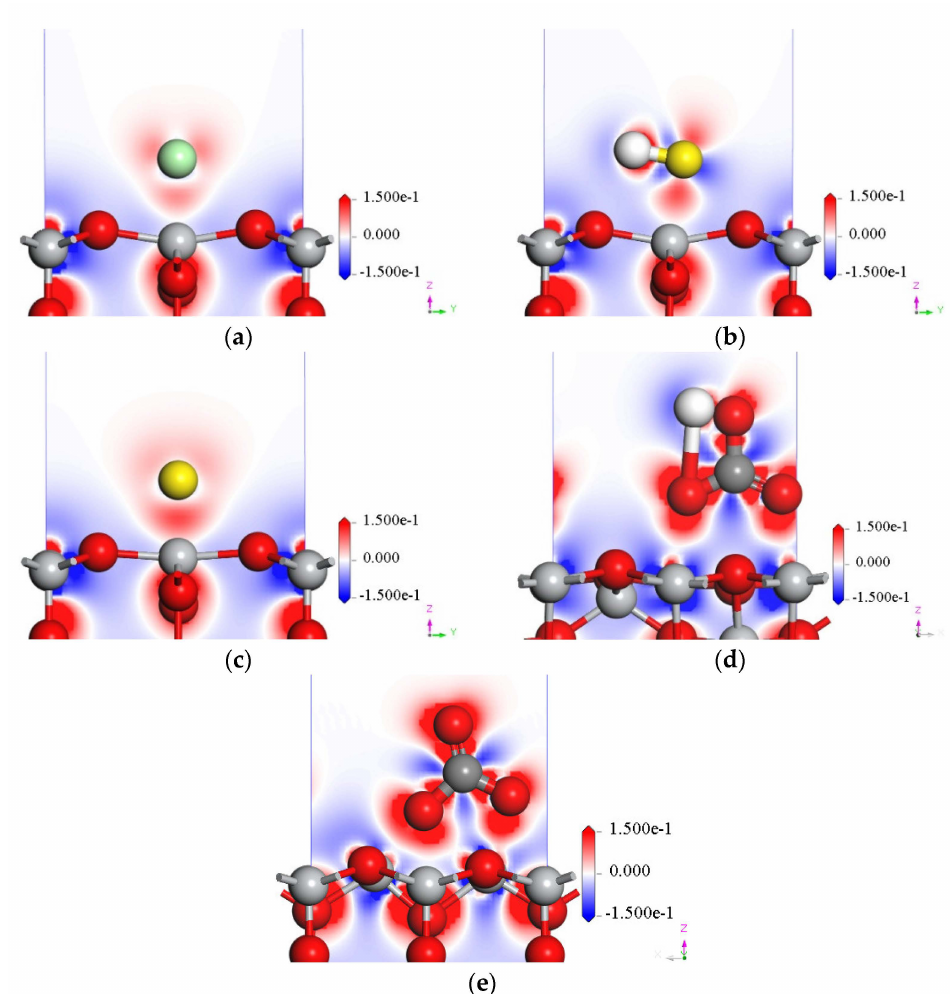
Figure 4. Electron density difference distribution of corrosive species at the bridge position on the TiO 2 (110) crystal face: ( a ) Cl − ; ( b ) HS − ; ( c ) S 2 − ; ( d ) HCO 3 − ; ( e ) CO 32 −